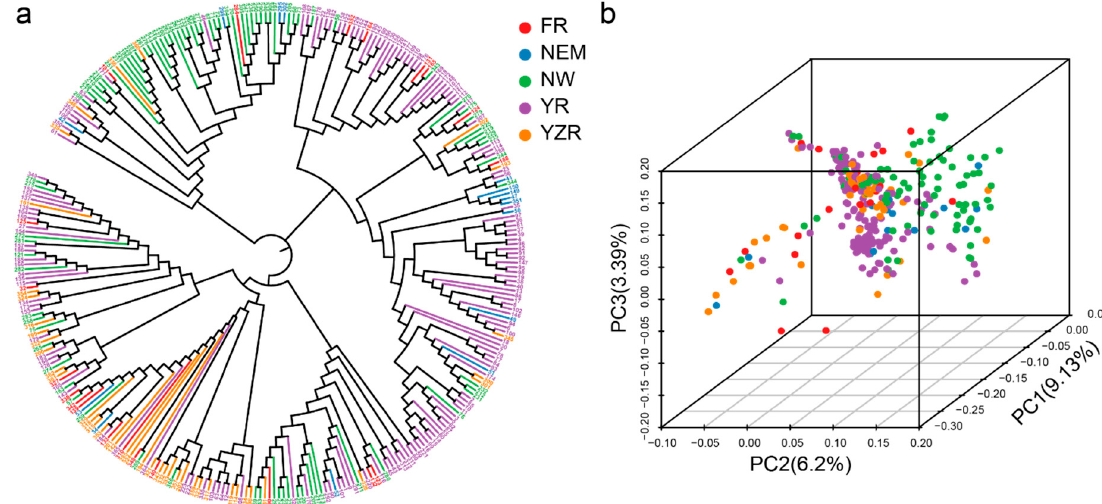
Figure 2. Population structure of 316 upland cotton accessions. ( a ) Phylogenetic tree of the natural population, FR: foreign region; NEM: the northern specific early maturation region; NW: the northwestern inland region; YR: the Yellow River basin region; YZR: the Yangtze River basin region; ( b ) Principal component analysis of upland cotton, each dot represents an accession.